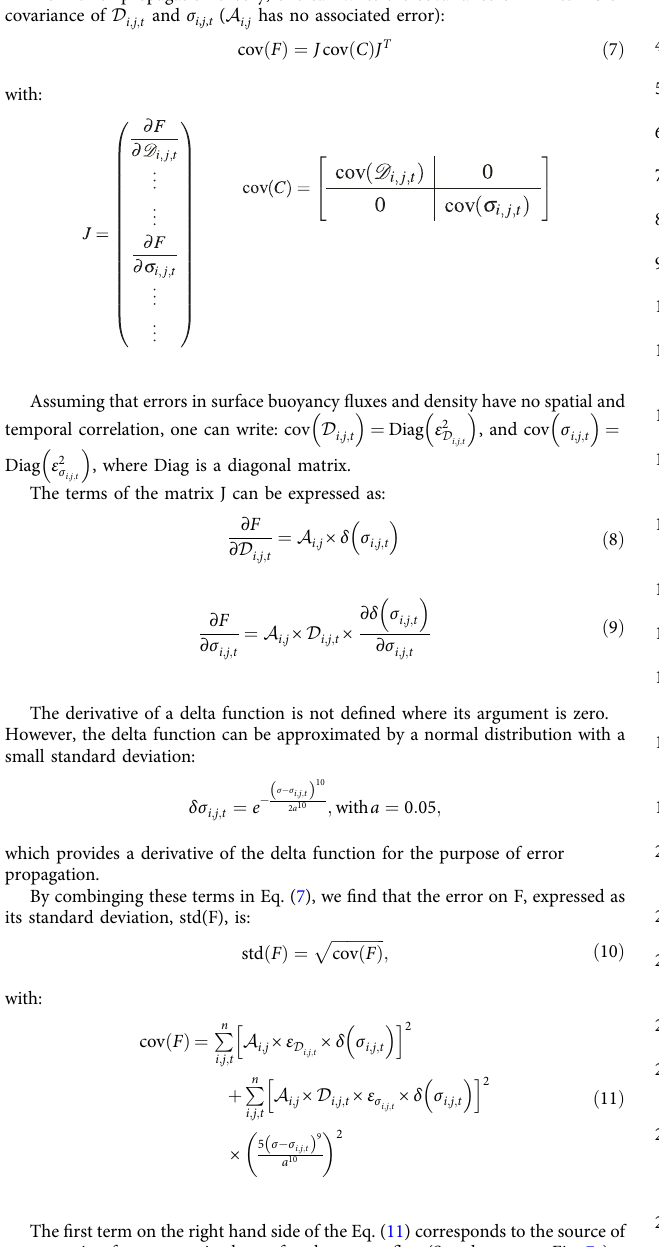
while the second term corresponds to the source of error coming from errors in the density fi eld (Supplementary Fig. 7b). The major source of error in the calculation